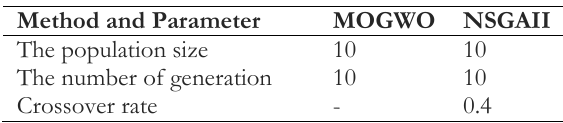
Table 2. Considered initial value for the parameters in two